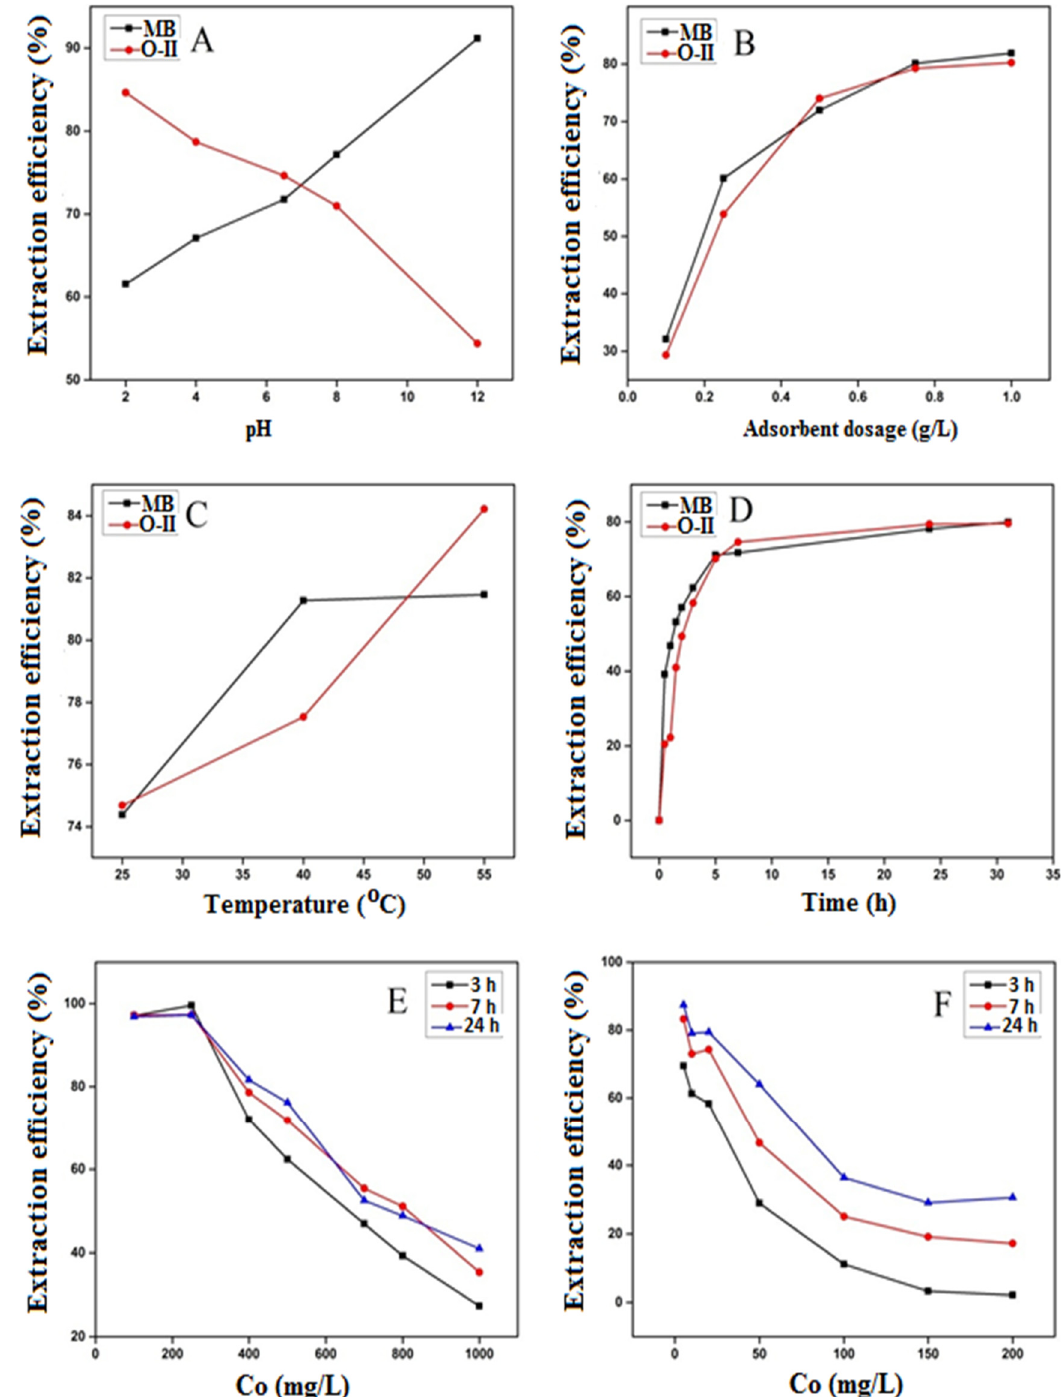
Figure 7. ( A ) Effect of pH (MB = 500 mg/L, O-II = 20 mg/L, m = 0.5 g/L, and t = 7 h), ( B ) adsorbent dosage (MB = 500 mg/L, O-II = 20 mg/L, pH = 7.0, and t = 7 h), ( C ) temperature (MB = 500 mg/L, O-II = 20 mg/L, m = 0.75 g/L, and t = 7 h), ( D ) contact time (MB = 500 mg/L, O-II = 20 mg/L, m = 0.75 g/L), ( E ) dye concentration (MB = 100–1000 mg/L, m = 0.75 g/L), ( F ) (O-II = 5–200 mg/L, m = 0.75 g/L).